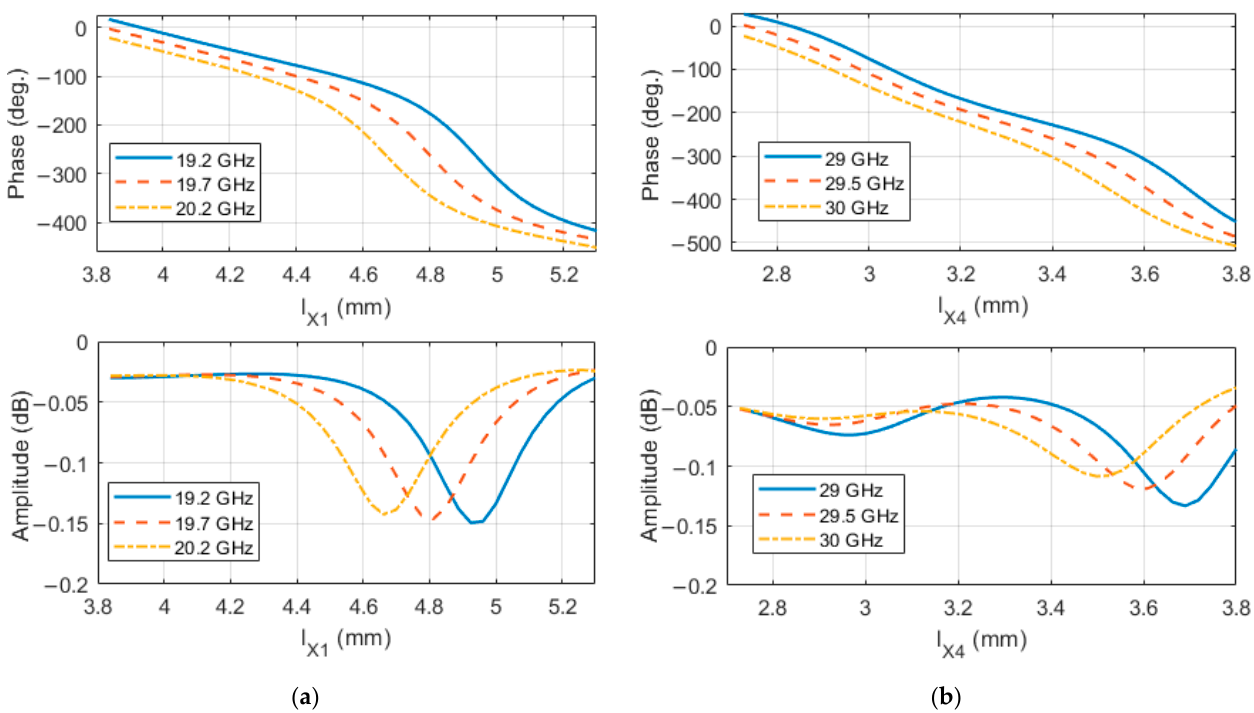
Figure 14. Phase and amplitude of the reflection coefficient associated with the x component of the incident field ( a ) at the lower band (19.2–20.2 GHz) and ( b ) at the upper band (29–30 GHz).